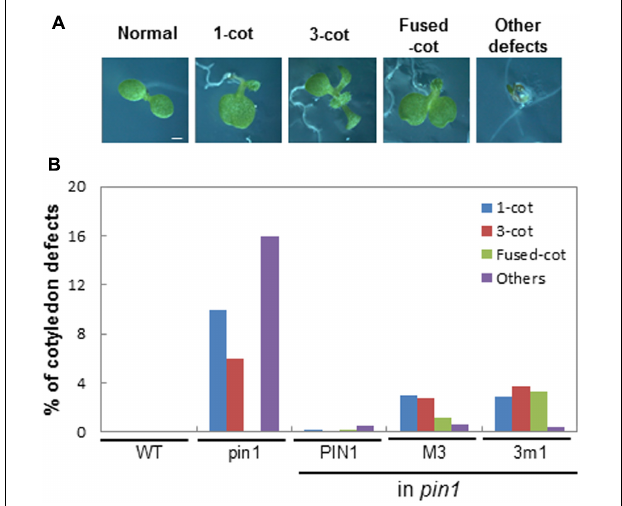
FIGURE 2 | Effect of M3 or 3m1 mutation of PIN1 on seedling development. (A) Six-day-old seedlings showing cotyledon defects by PIN1 mutations. Bar = 0.5 mm for all. (B) Quantification of cotyledon defects shown in (A) . All the segregated F1 progeny seedlings of self-fertilized heterozygous pin1 ( ± ) mutant background were observed for pin1 and pin1 with PIN1 ( ProPIN1:PIN1:GFP ), M3PIN1 (M3, ProPIN1:M3PIN1:GFP ), and 3m1PIN1 (3m1, ProPIN1:3m1PIN1:GFP ). Total 403–485 seedlings from 7 to 8 independent lines per construct were observed. cot, cotyledon; WT,